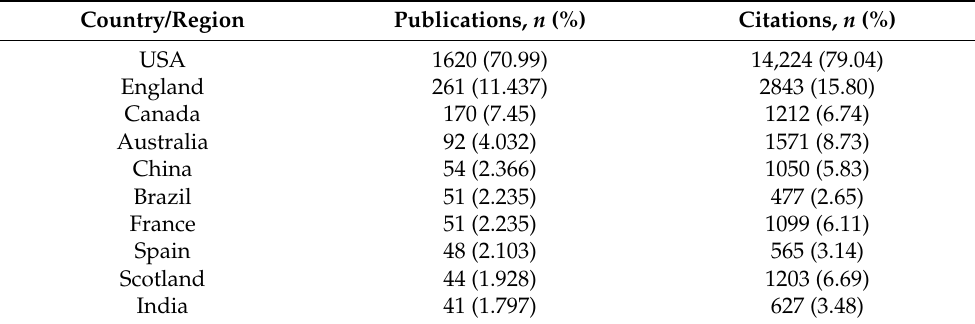
Table 2. Top 10 productive